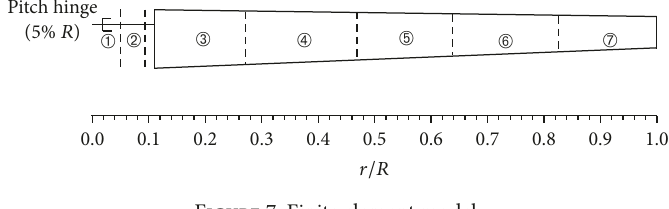
Figure 7: Finite element model.